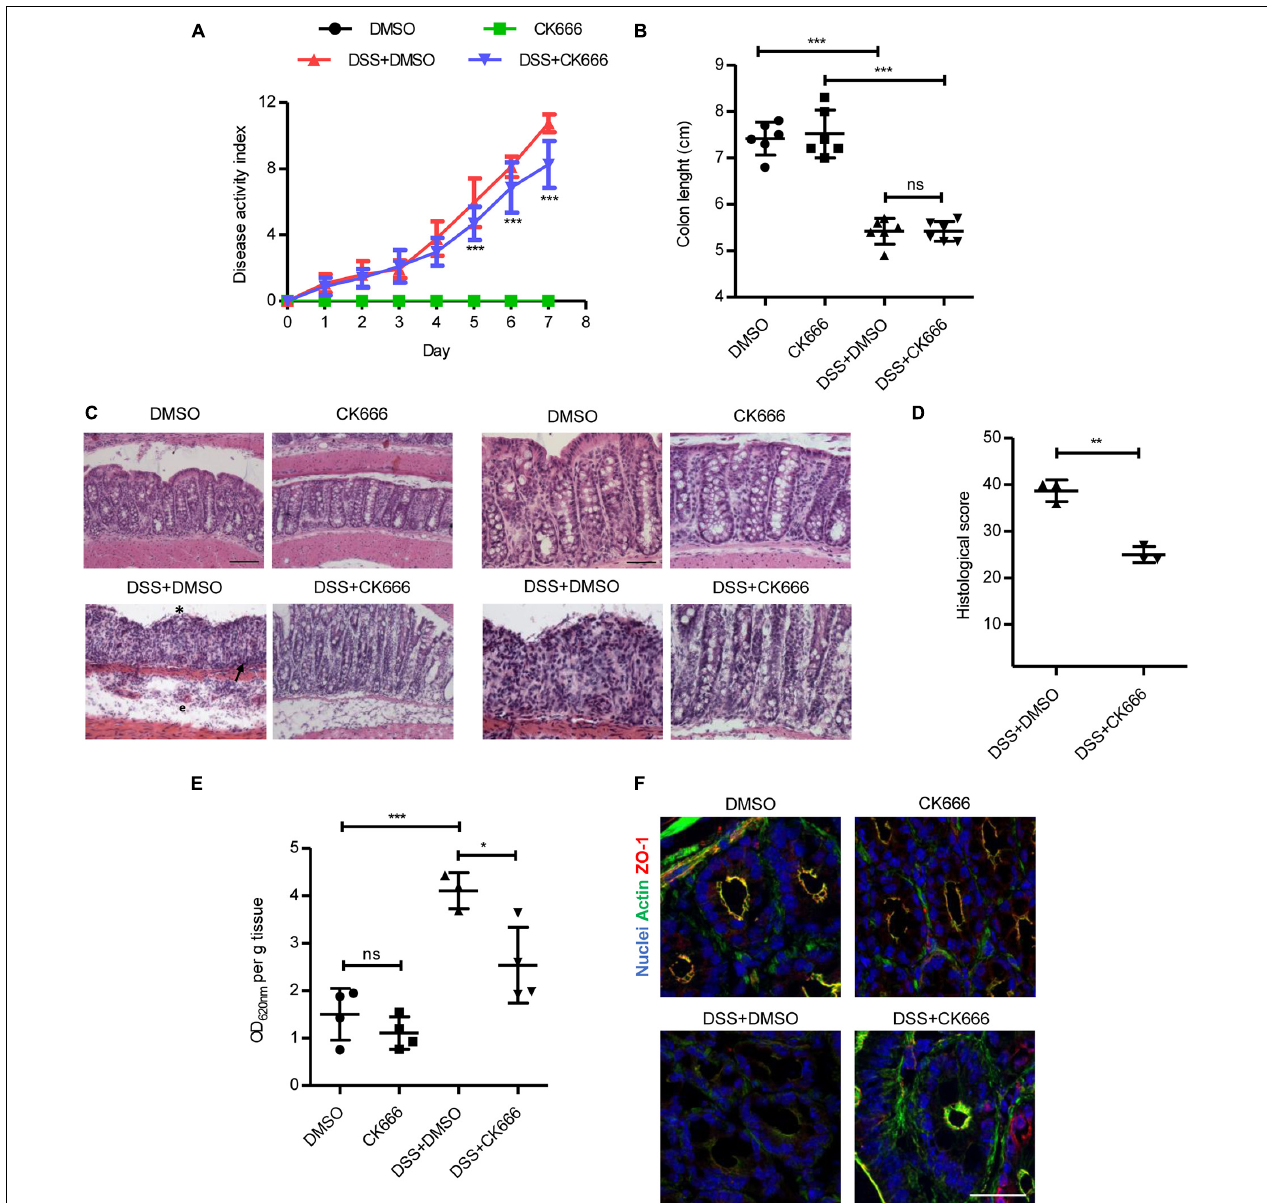
FIGURE 6 | CK666 ameliorates tissue damage in a dextran sulphate sodium (DSS)-induced colitis mouse model. (A) Disease activity index of mice with DSS-induced colitis and treated with either the vehicle dimethylsulfoxide (DMSO) or 5 mg/kg CK666 intraperitoneally (i.p.) starting on day 3 ( n = 8–9 per group; two-way ANOVA with Bonferroni’s correction). (B) Colon lengths after DSS-induced colitis ( n = 6 per group; one-way ANOVA with Bonferroni’s correction). (C) Hematoxylin/eosin-stained colon tissue sections in 20 × magnification (left) and 40 × (right). Bars = 50 µ m (left), 25 µ m (right). Crypt dysplasia and ulceration (*), immune cell infiltration (arrow), and edema formation (e) are highlighted; n = 3 per group. (D) Histological inflammation score of colitic mice ( n = 3 per group; two-tailed test). (E) Colon permeability to Evans blue in control and colitic mice treated with either DMSO or CK666 ( n = 4 per group; one way-ANOVA with Bonferroni’s correction). (F) Immunostaining of zonula occludens 1 (ZO-1) (red) and actin (green) in colon tissue from control and colitic mice treated with DMSO or CK666; n = 3. Bar = 35 µ m. * p < 0.05; ** p < 0.01; and *** p < 0.001. ns = not